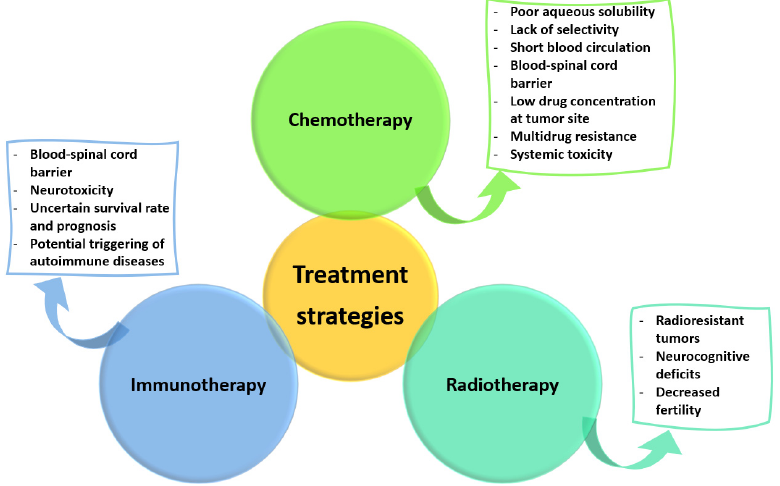
Figure 1. Limitations of current non-surgical treatment strategies. Created based on information from [30,49–52,54]